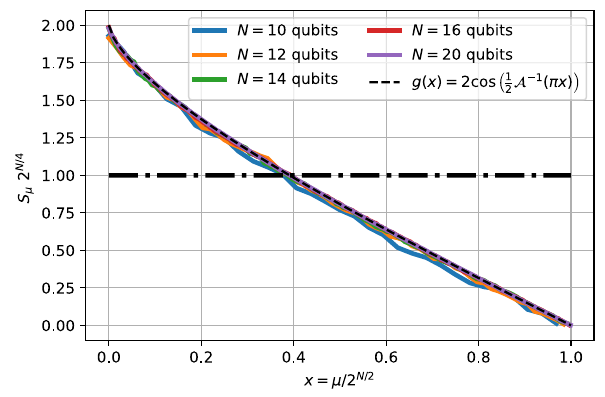
FIG. 16. Scaling behavior of the Schmidt coefficients (singular values) S μ of a Porter-Thomas wave vector for various numbers of qubits N . Black dashed line denotes the scaling function g ( x ) . Black dash-dot line denotes the constant singular values case ( S μ = 1 / 2 N / 4